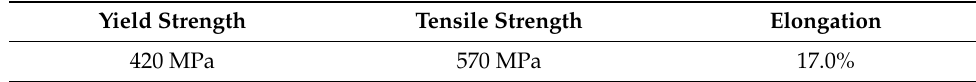
Table 2. Mechanical properties of A2024-T3 (Specimen P).